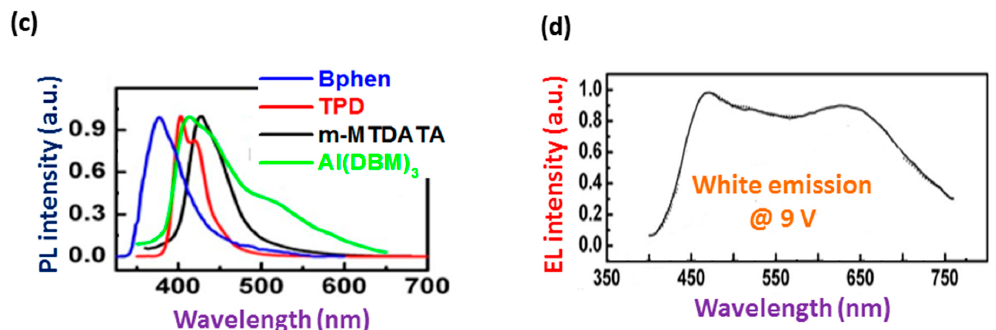
Figure 2. ( a ) Energy-level diagram of the white organic light-emitting diodes (WOLEDs). ( b ) Electroluminescence (EL) spectra of four organic light-emitting diodes (OLEDs): EL-1, EL-2, EL-3, and EL-4, where emission peaks appear at about 463, 528, 572, and 650 nm, respectively. ( c ) Photoluminescence (PL) spectra of m-MTDATA, TPD, Bphen, and Al(DBM) 3 films excited at 360 nm. ( d ) EL spectrum of the WOLED with x = 3 nm and R = 1:2 at 9 V (Reproduced from [159]).